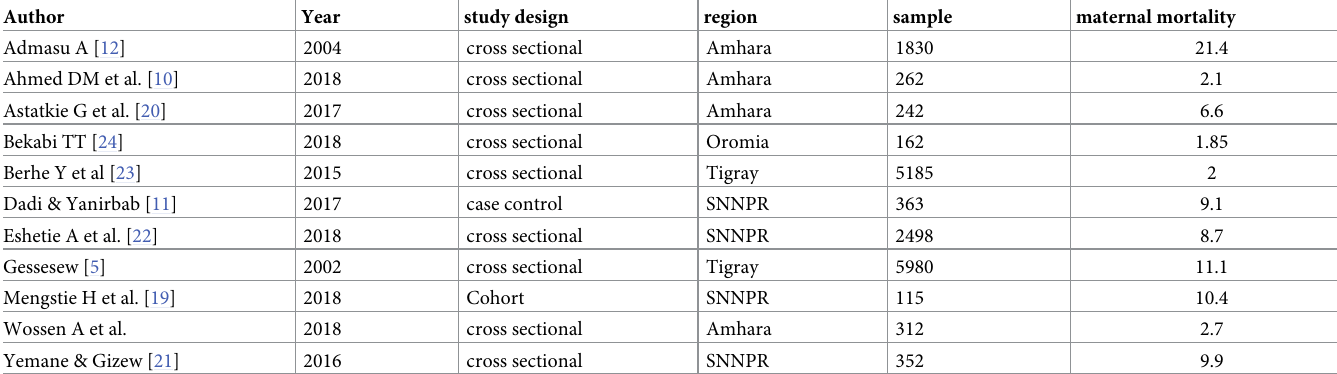
Table 1. Characteristics of included studies in